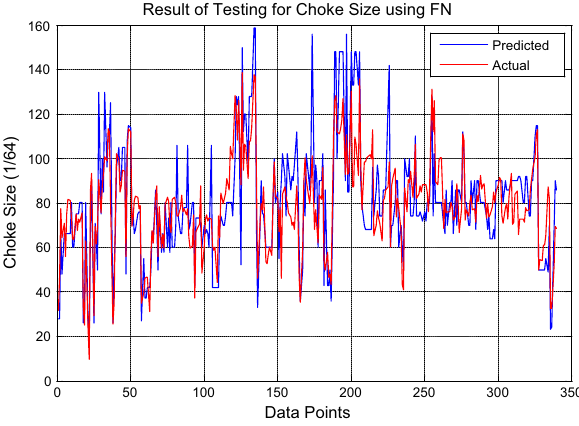
Fig. 22 Correlation between the actual and the predicted choke size for training data (Gaussian function) ( R = 0.75)